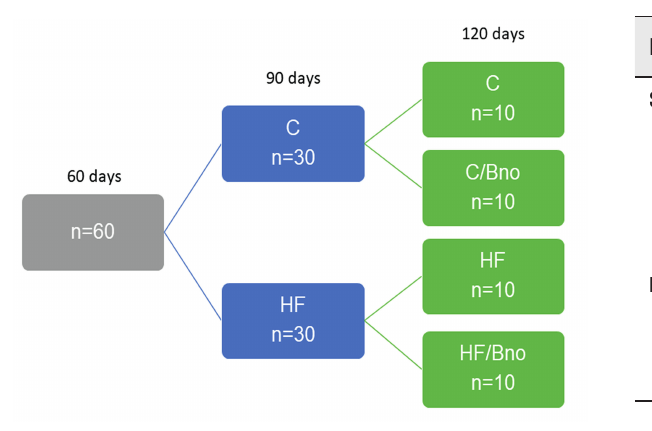
Table 2 - Principal lipids from Brazil nut oil. Figure 1 - Study